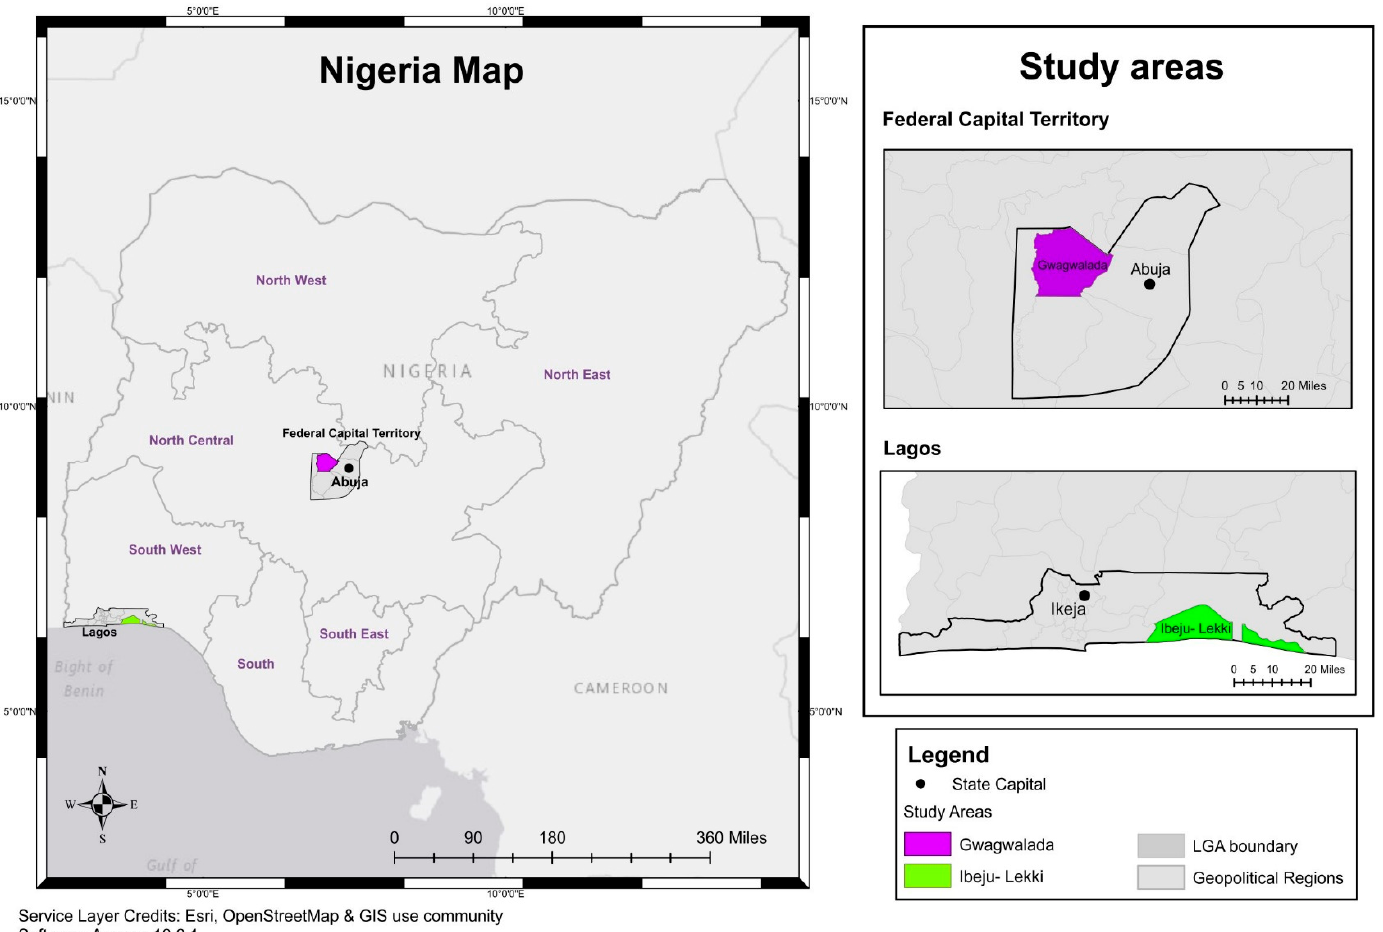
Figure 3. Map of Nigeria showing the states and local government areas (LGA) where the energy surveys were performed. Note that the FCT does not have LGAs, but instead is made up of Area Councils, of which Gwagwalada is one.